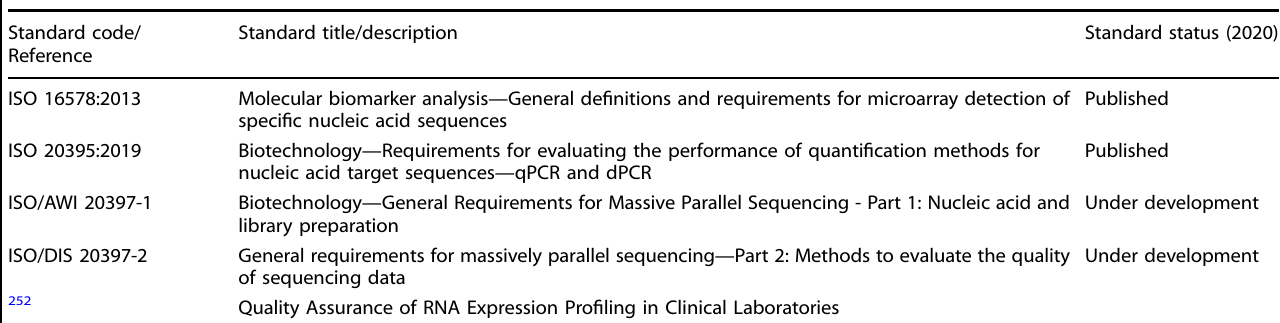
Table 2. ISO standards and literature applicable for gene expression